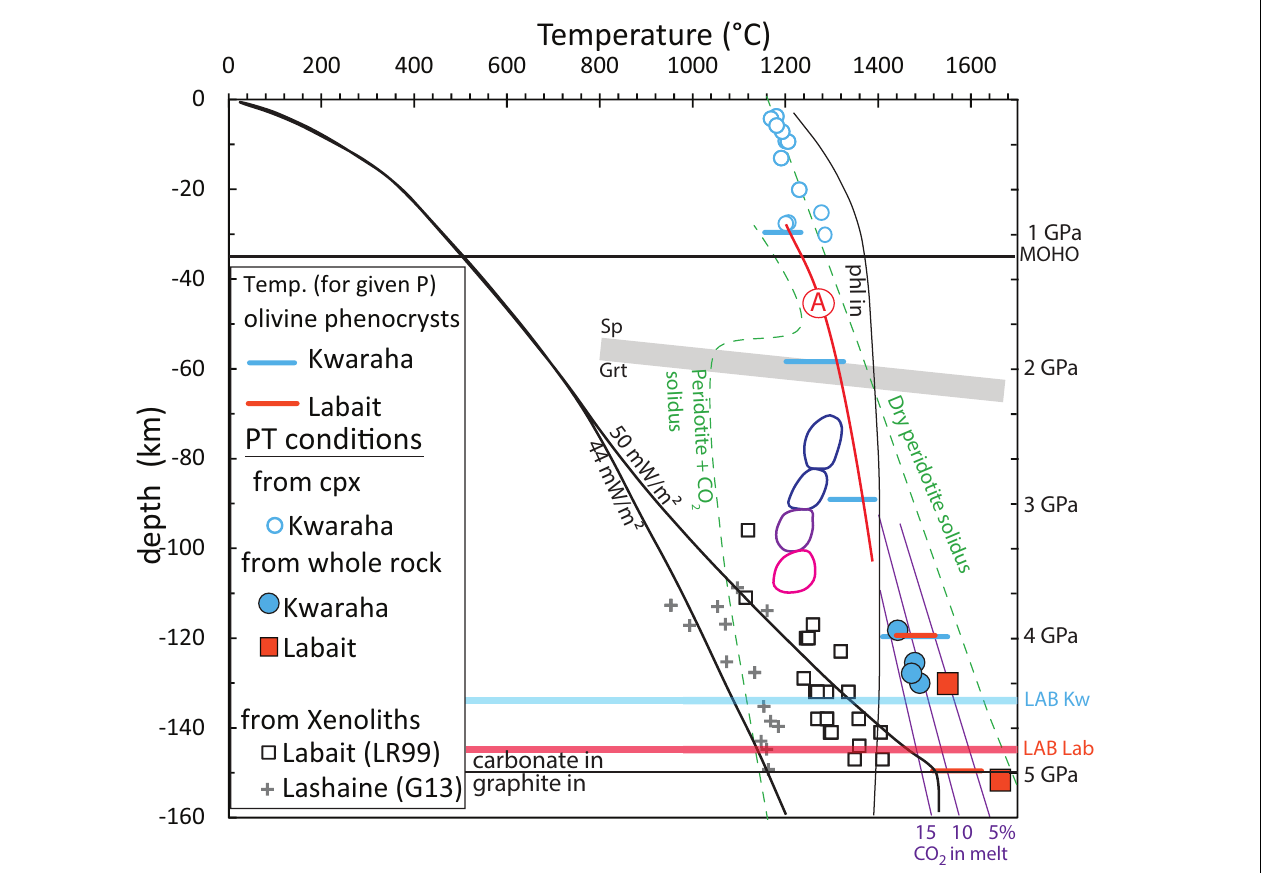
FIGURE 10 | P-T conditions of clinopyroxene crystallization calculated from the clinopyroxene-liquid thermobarometer (Putirka, 2008) for Kwaraha (Mg# > 65) and P-T conditions of partial melting (Albarède, 1992) for Kwaraha and Labait lavas. P-T conditions for Labait and Lashaine mantle xenoliths are from Lee and Rudnick (1999) LR99 and Gibson et al. (2013) G13, respectively. Crystallization temperatures of olivine are represented by color bars (blue: Kwaraha, and orange; Labait; calculation from Putirka, 2008). We include the dry peridotite and peridotite+CO 2 solidi and melt CO 2 isopleths with CO 2 content in weight percent from Dasgupta et al. (2013), the spinel-garnet boundary from Lee et al. (2000), and the lithosphere-asthenosphere boundary (LAB) from Craig et al. (2011). The curve of phlogopite stability (phl) correspond to experiments (KMASH) from Yoder and Kushiro (1969); Sato et al. (1997), and Trønnes (2002). The reaction (A) F-phl+cpx+grt = ol+opx+melt has been determined from melting experiments of phlogopite-garnet peridotite by Condamine et al. (2016). Cratonic geotherm (44 mW/m 2 ) and geotherm modified by plume thermal anomaly are also reported (Selway et al., 2014), as well as the different melt types produced by low partial melting of CMAS ± H 2 O and CO 2 : Colored balloons represent P and T conditions of partial melting for basanite (blue balloon), nephelinite, melilitite, and leucitite melt compositions (pink balloon) (Frey et al., 1978; Adam, 1990; Green and Falloon, 1998).